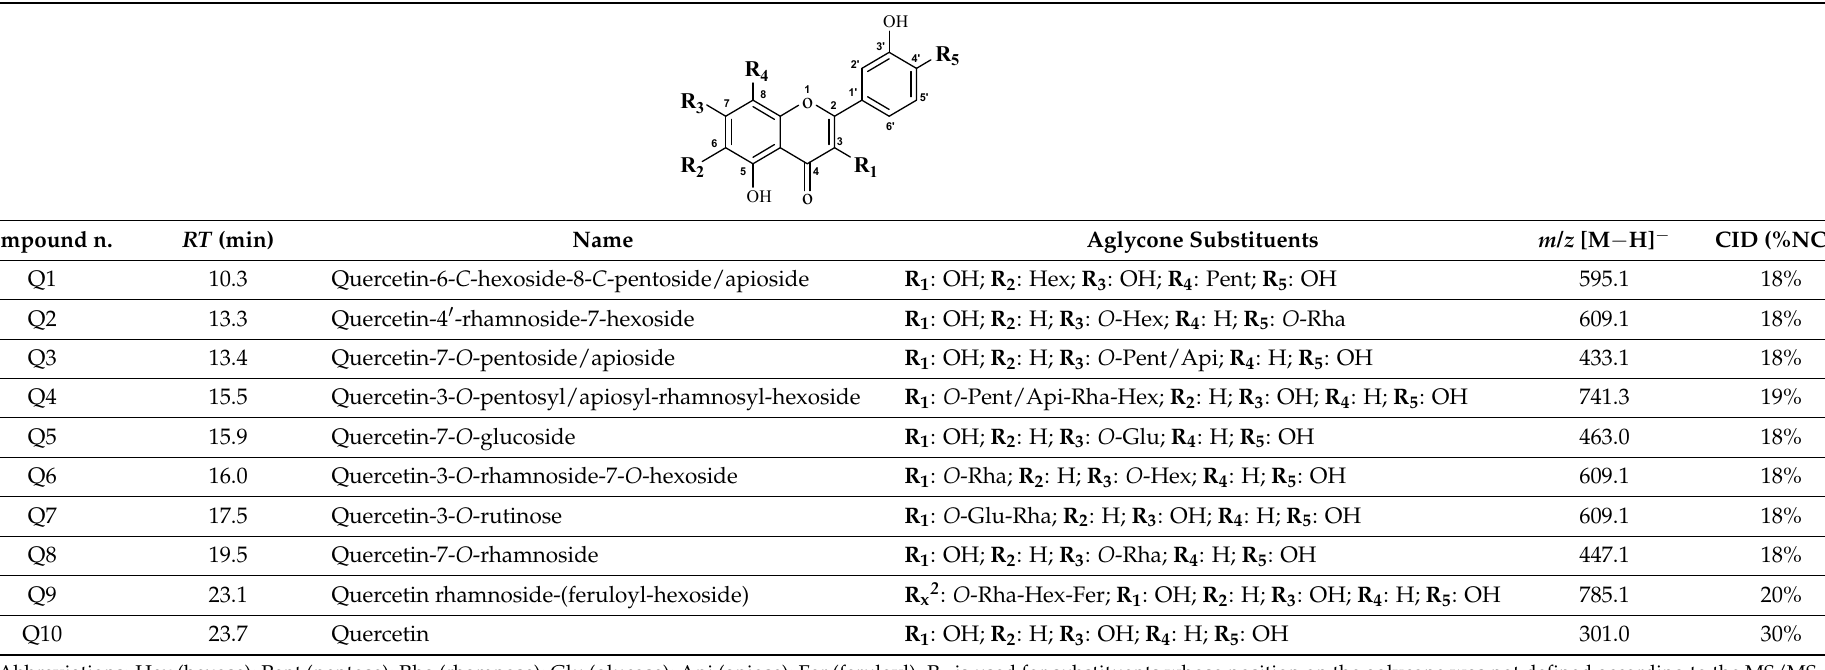
Table 1. Quercetin derivatives identified in the methanolic extract of peppers derived from a crossing combination between Habanero white and Capsicum annuum spp.